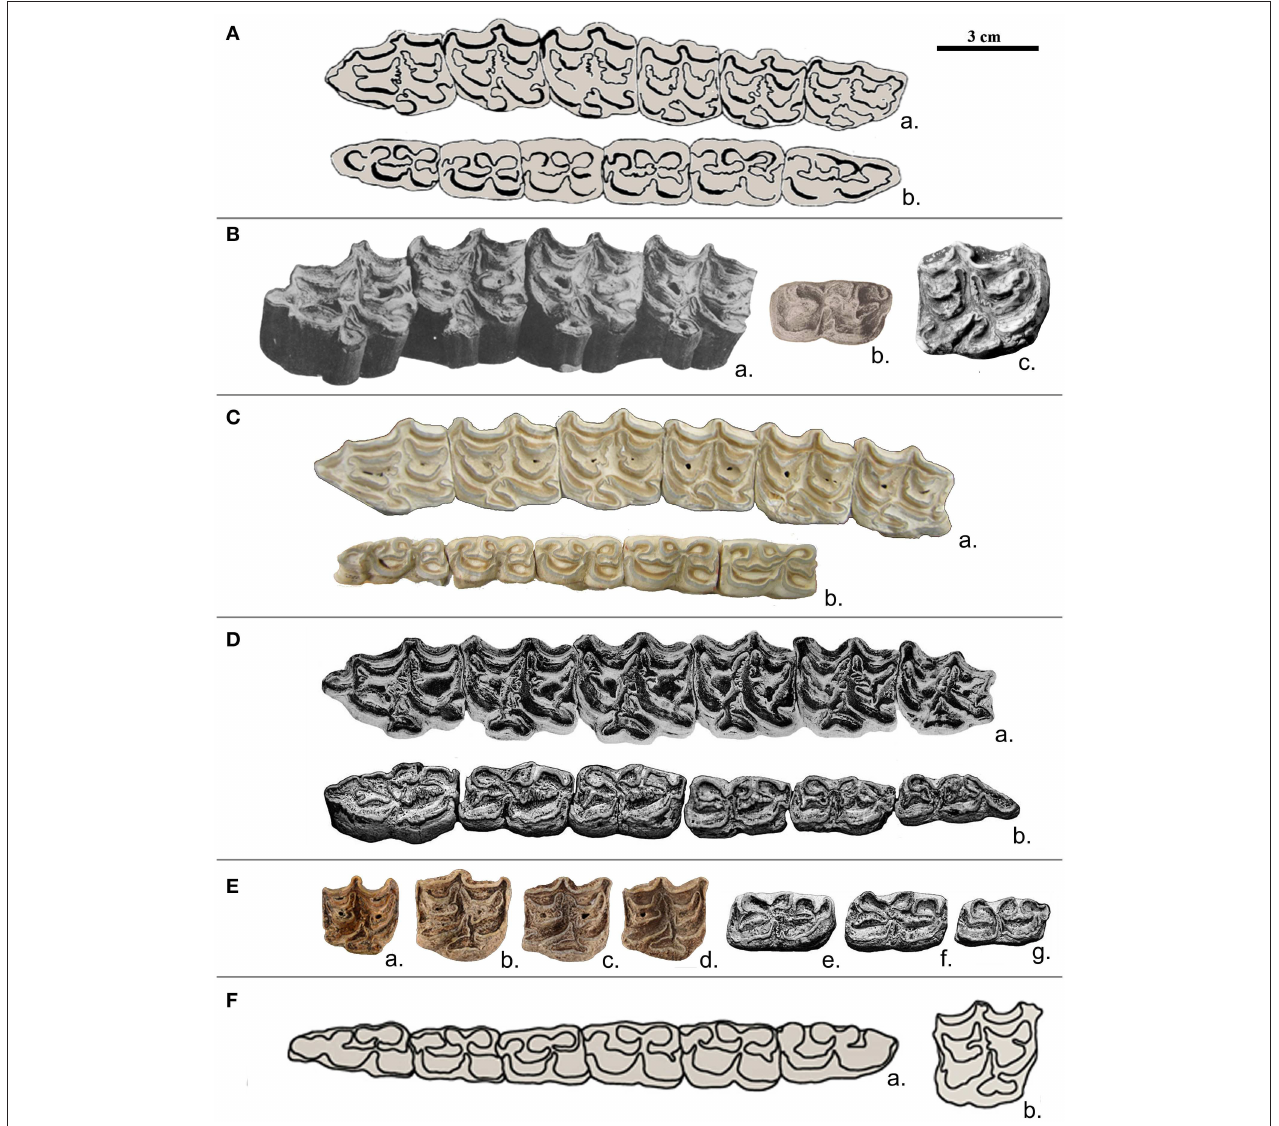
FIGURE 3 | Upper and lower cheek teeth from different Pleistocene equids. Occlusal view. (A) Equus stenonis , Upper Valdarno, a- left P2-M3, Type; b-right P2-M3 (after Azzaroli, 1965 in Caloi, 1997). (B) Equus major , Chagny, a-left P2-M1, b-left M2 (Delafond and Depéret, 1893); c-right P34, se 338, Senèze (Eisenmann, 2017). (C) Equus granatensis , Venta Micena, a-left P2-M3, Type, b-right P3-M3, VM 8297 (Boulbes, pers. photo). (D) Equus suessenbornensis , Süssenborn, a-left upper cheek teeth P2-M3, Type, b-left lower cheek teeth, P2-M3, S 6882 (Eisenmann, 2008). (E) Equus altidens (including E. marxi ), Süssenborn, a-right P4, S 1365, M1, S 1366, M2, S 1367, b-left P3, S 1369, P4, S 1368, M2 (S 1370) (Eisenmann, 2019). (F) Equus apolloniensis , Apollonia P-1, a-right P2-M3, APL 147, b-right P4, APL 148 (after Koufos et al., 1997, in Eisenmann and Boulbes, in